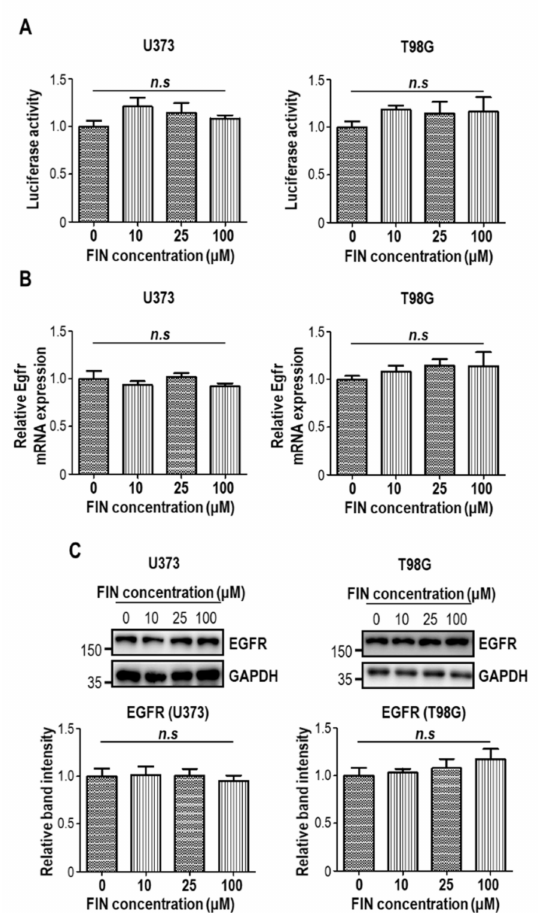
Figure 5. Finasteride does not alter EGFR expression. ( A ) Relative amount of luminance from U373 (left) and T98G (right) cells transfected with Gaussia luciferase (GLuc) reporter plasmid-containing EGFR promoter upon treatment of DMSO or finasteride (FIN) at the indicated concentration for 24 h. n.s. , not significant. ( B ) The mRNA expression of Egfr in U373 (left) and T98G (right) cells upon vehicle or FIN treatment, as measured by quantitative RT-PCR analysis. The mRNA level of vehicle-treated cells was set to 1. n.s. , not significant. ( C ) Immunoblot analysis of EGFR in U373 (left) or T98G (right) cells after treatment with vehicle or FIN at the indicated concentration for 24 h. GAPDH was used as a loading control. The relative band intensities of the EGFR are shown below. The intensities of vehicle-treated samples were arbitrarily set to